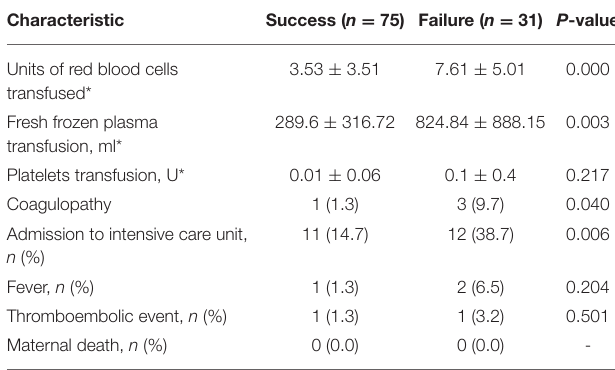
TABLE 3 | Management of complications of PPH undergoing intrauterine balloon tamponade.